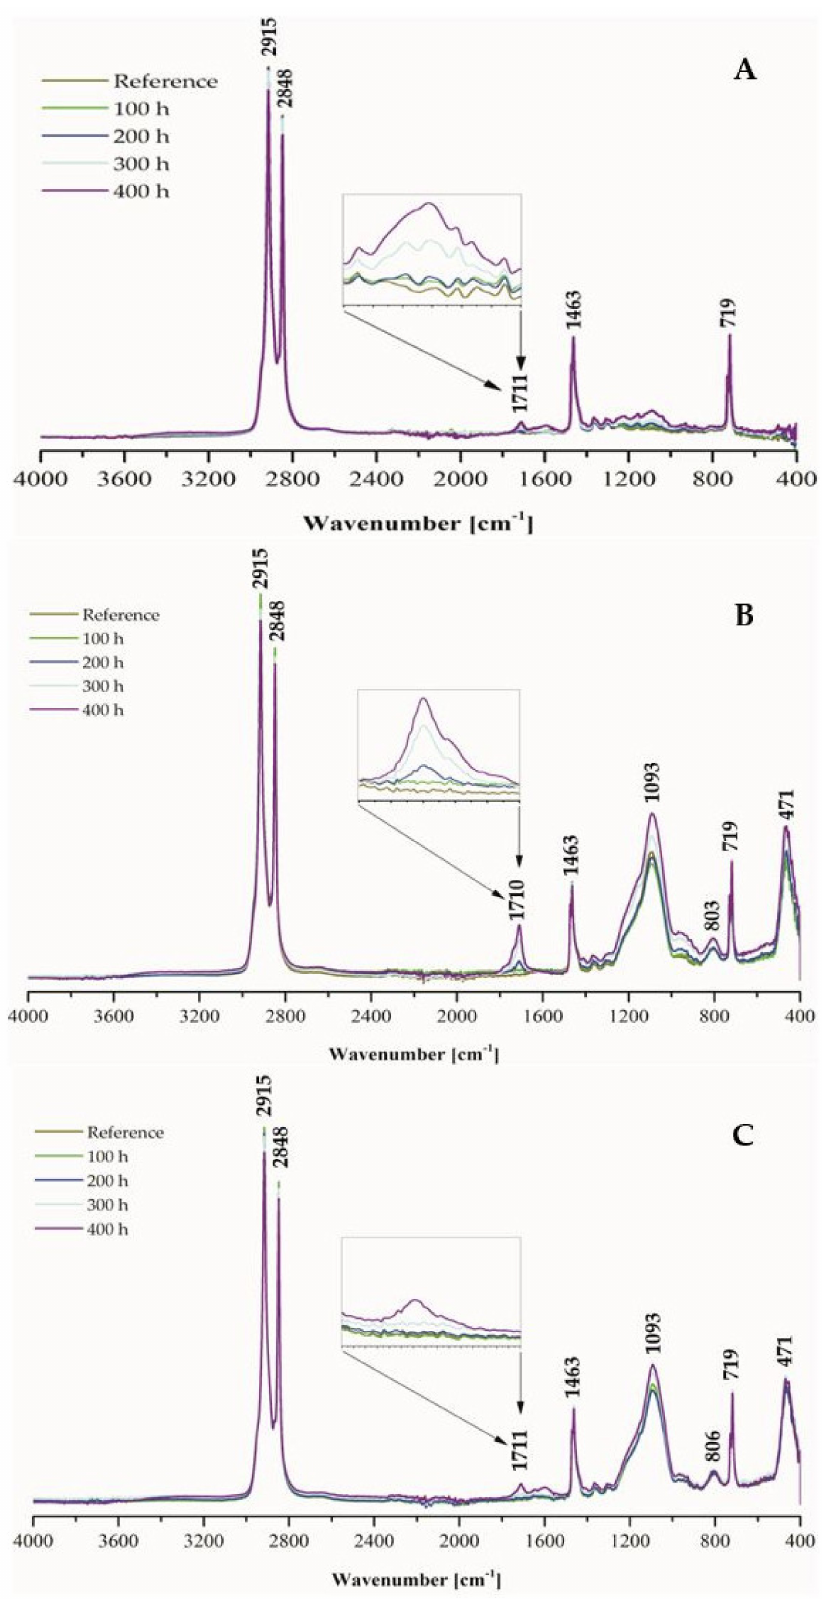
Figure 2. Fourier—transform infrared spectra of: ( A ) pure Topas, ( B ) Topas with silica, ( C ) Topas with silica and hesperidin, before and after 100, 200, 300 and 400 h of